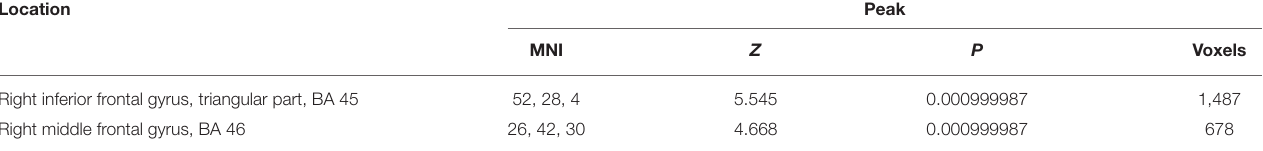
TABLE 3 | Brain regions engaged during timing